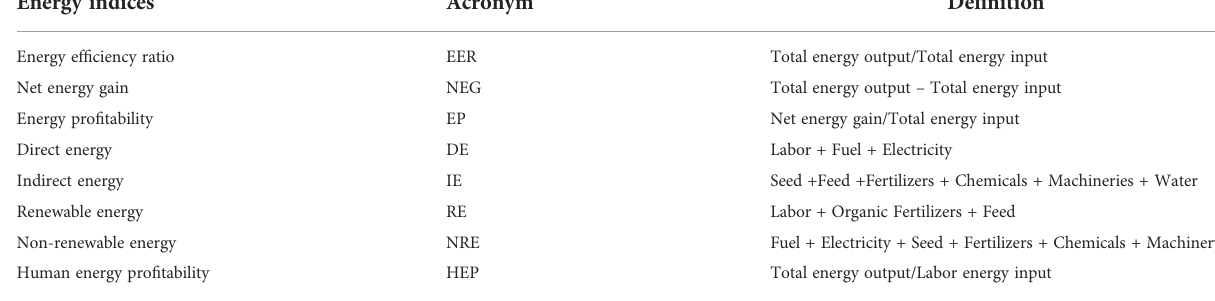
TABLE 3 List of formulae used for calculation of different energy